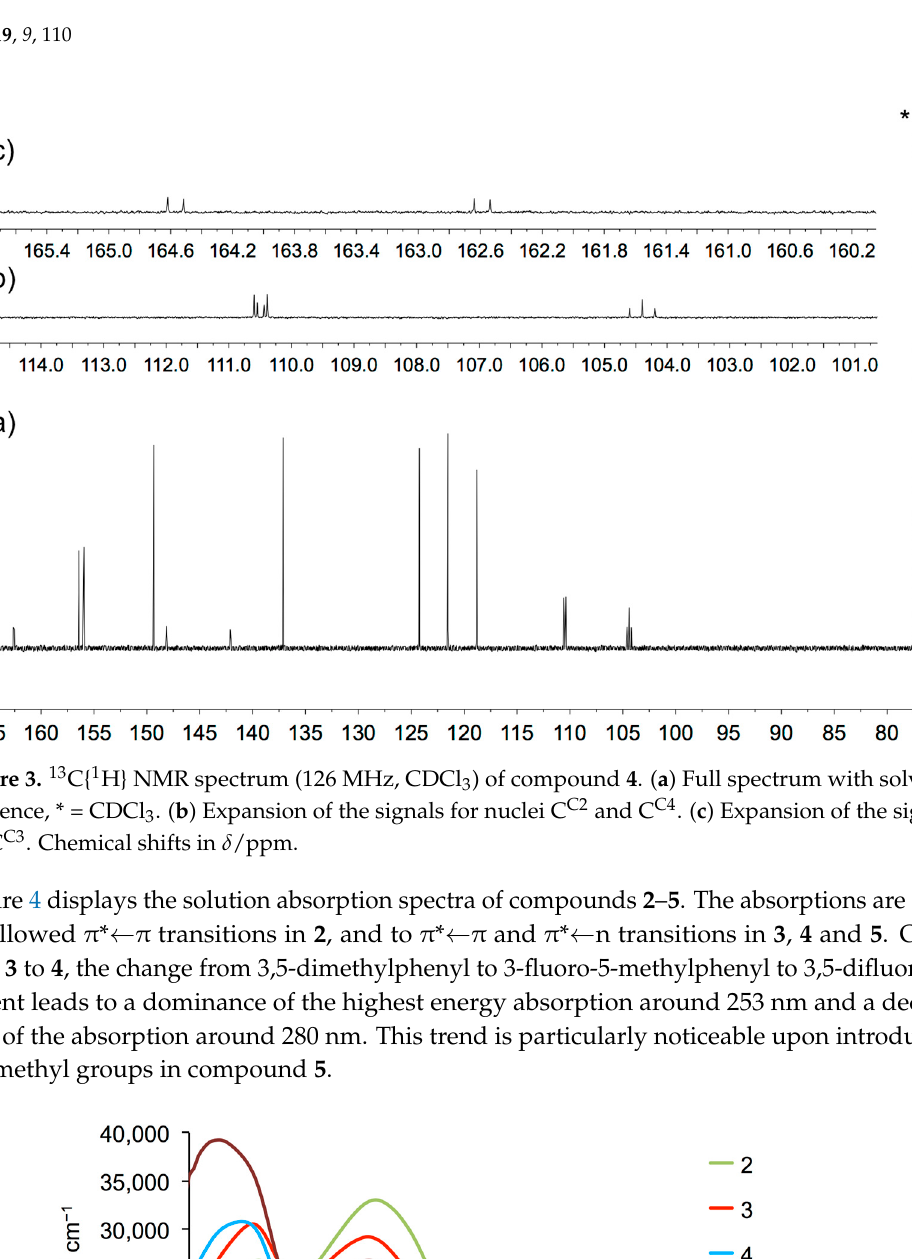
Figure 2 . Part of the NOESY spectrum of compound 3, showing the cross-peak between the signals for H B3 and H C2 .